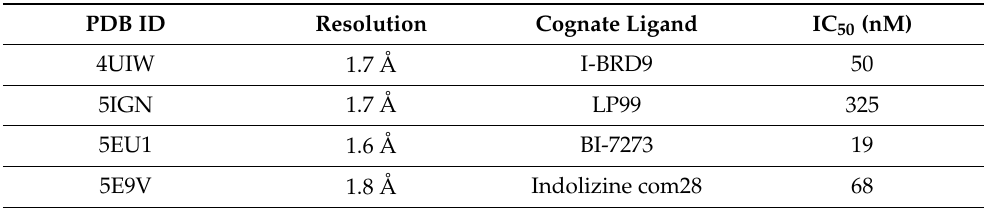
Table 5. List of BRD9 inhibitors that have been used in the development of the pharmacophore model, along with their PDB IDs, resolutions and IC 50 /K d (nM)